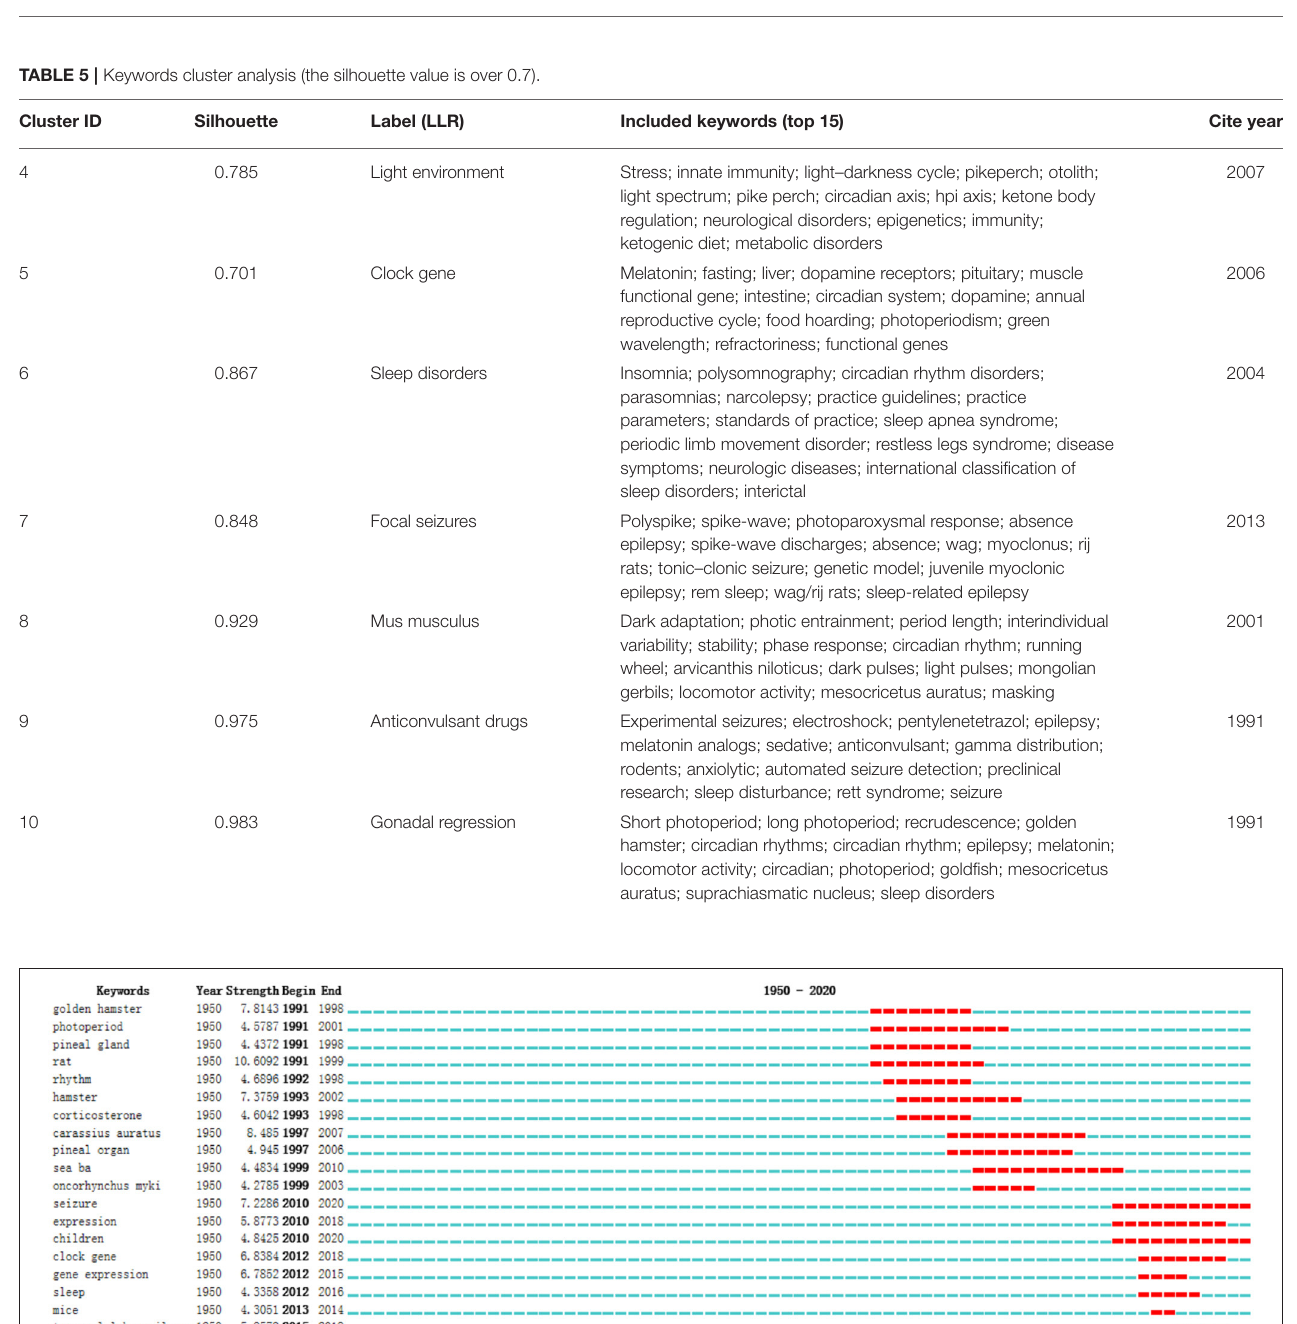
Clock Genes Cluster #5 indicated the vital role of clock genes in the circadian variation of epileptic excitability in epilepsy. By performing transcriptome analysis on human epileptogenic tissue, Li et al. (32) reported that disruption of clock circadian